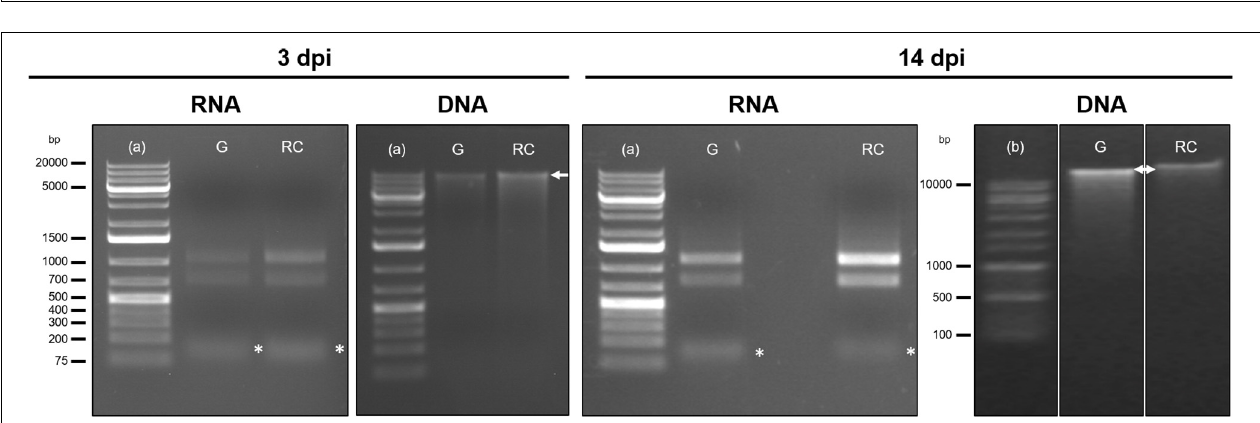
FIGURE 2 | DNA and RNA extraction efficiency for gall and control roots. (A) At 3 days post infection (dpi), (B) at 14 dpi. Y -values represent the amount of total genomic DNA and total RNA, obtained from all eluates. Below the graphic, the A 260 /A 280 (upper line) and A 260 /A 230 (lower line) ratios are indicated for each sample (when the eluates were not pooled together, the ratios represented are from the first eluate). From left to right – Black bars represent the total amount of genomic DNA or RNA, as indicated, from 300 galls at 3 dpi to 250 galls at 14 dpi. White bars represent the total amount of genomic DNA or RNA, as indicated, extracted from 1000 segments of control uninfected root tissue equivalent to galls at 3 dpi and 500 equivalent to galls at 14 dpi.